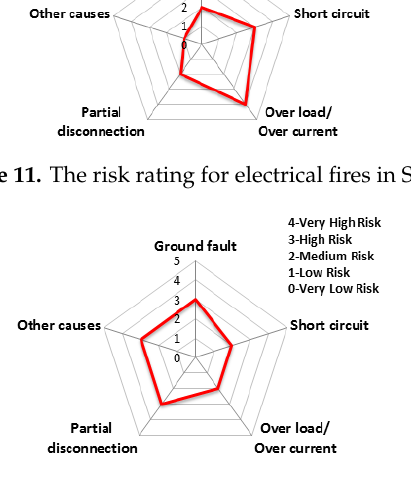
Figure 12. The risk rating for electrical fires in Busan.